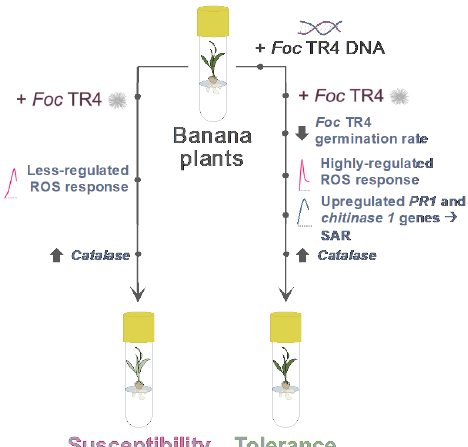
Figure 5. Mechanisms of Foc TR4 DNA in shifting banana plants’ susceptibility towards tolerance through suppression of fungal spore germination and priming plant defense. Priming action involves a precise upsurging of ROS (O 2 − and H 2 O 2 ) for signal cascading and quenching before reaching oxidative stress (elevated expression of catalase ). Following this, systemic acquired resistance (SAR) is activated, as indicated by the upregulation of PR 1 and chitinase 1 genes.